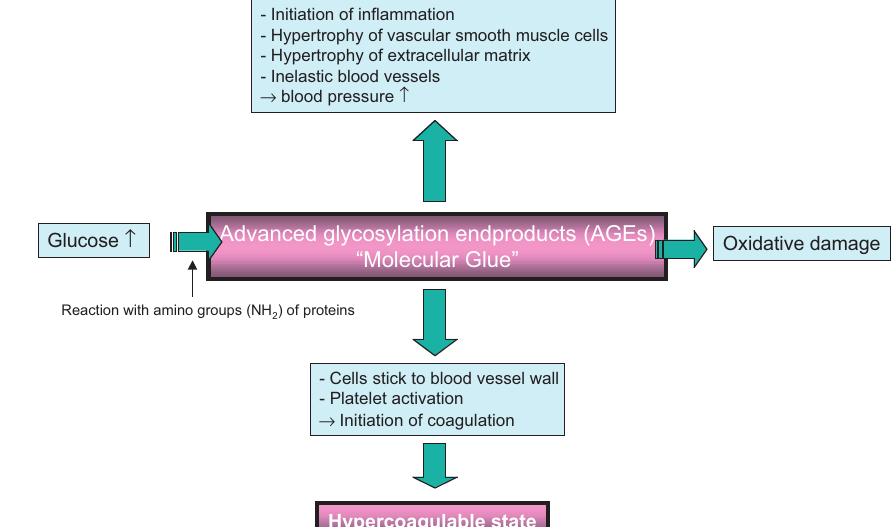
AGEs: Initiation of vascular remodelling and coagulation. Ad- vanced glycosylation endproducts (AGEs) act as a molecular glue. This initiates many adverse reac- tions leading to in- flammation, cellular remodelling, oxida- tive damage and